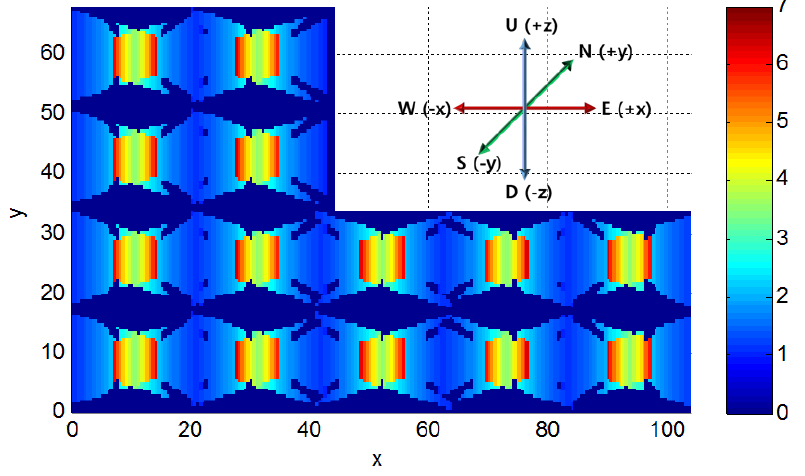
Figure 6. Surveillance resolutions when objects are on the ground and their orientations are upper vertical (blue: resolution = 0 px/cm; red: resolution = 7